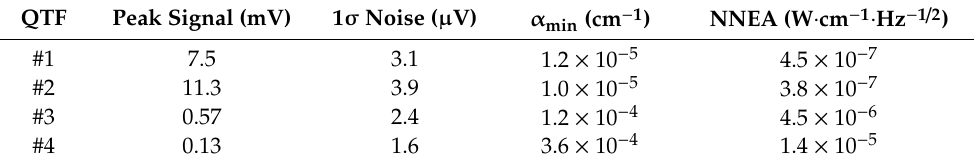
Table 4. 1 σ noise level, minimum absorption coe ffi cient ( α min ), and normalized noise equivalent absorption coe ffi cient (NNEA) of the QEPAS sensor, for each QTF employed in this